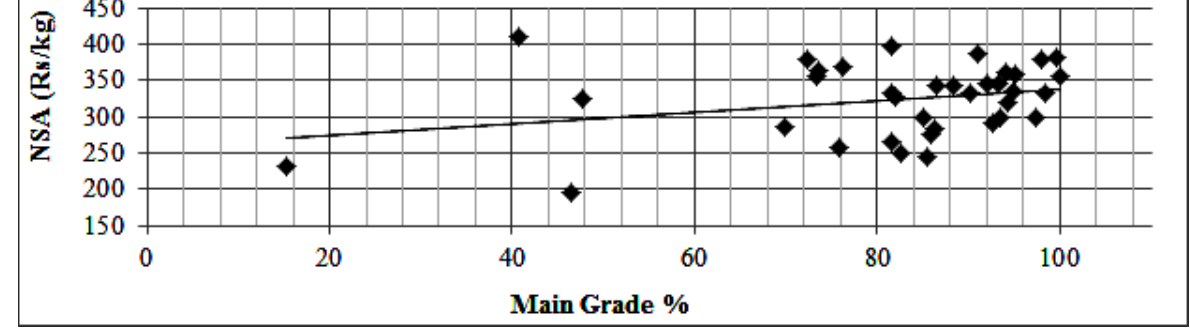
Fig 9: Relationship of Main Grade Percentage with NSA in Nuwara Eliya Own leaf quantity with NSA (see fig 10) shows weak relationship compared to the main grade percentage with NSA (see fig 9). Even though they have used same own leaf quantity, different NSA is resulted due to quality difference in raw material and changing favorable climatic conditions throughout the time period (Nuwara Eliya is getting their flavor season in January to